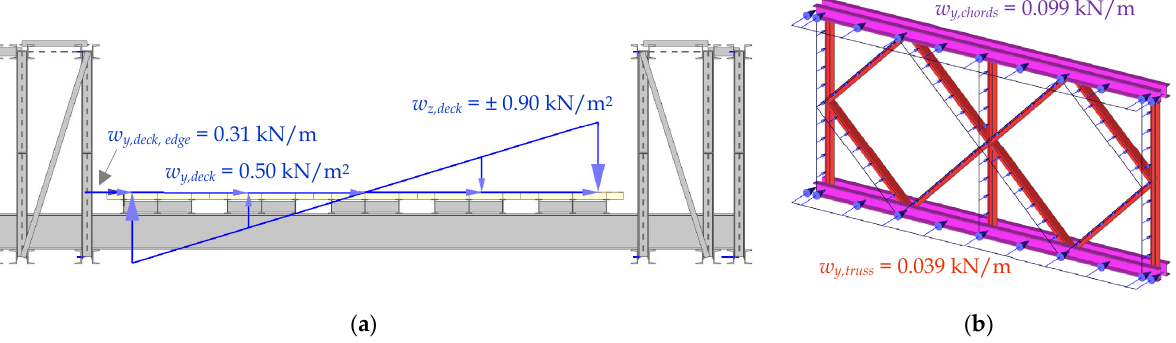
Figure 10. Example view from approximation of wind load: ( a ) left wind action on deck with traffic load on it; and ( b ) wind load assumed on main girders BB panels.